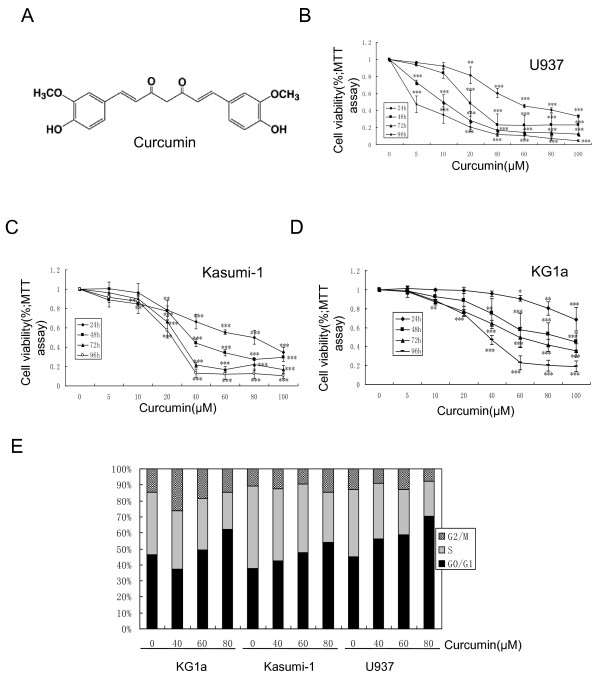
Curcumin suppressed cell growth and induced G1/S arrest. (A) Structure of curcumin. (B, C, D) KG1a, Kasumi-1 and U937 cell lines were treated with different concentrations of curcumin for 24, 48, 72, and 96 h. MTT assay was performed. (E) These three cell lines were treated with different concentrations of curcumin for 24 h and analyzed for DNA content by flow cytometry, as described in "Methods." The bar represents means ± SD of three independent experiments.